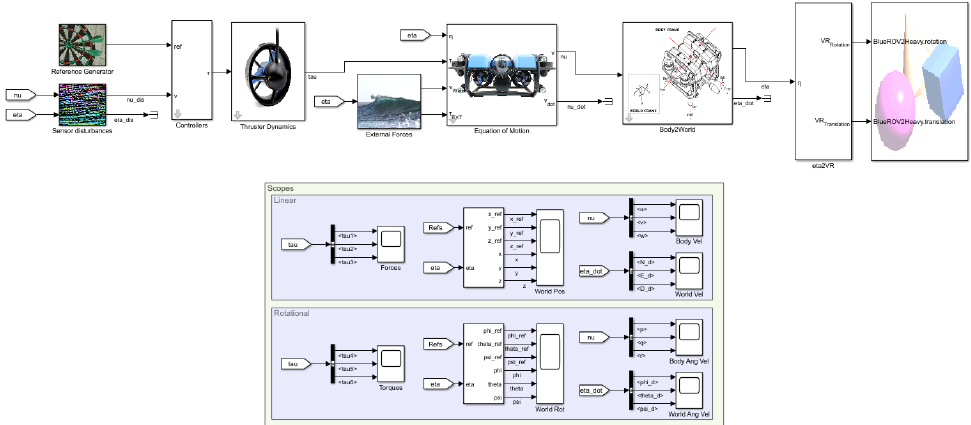
Figure A7. Overview of the simulation structure of the simulation file as seen in